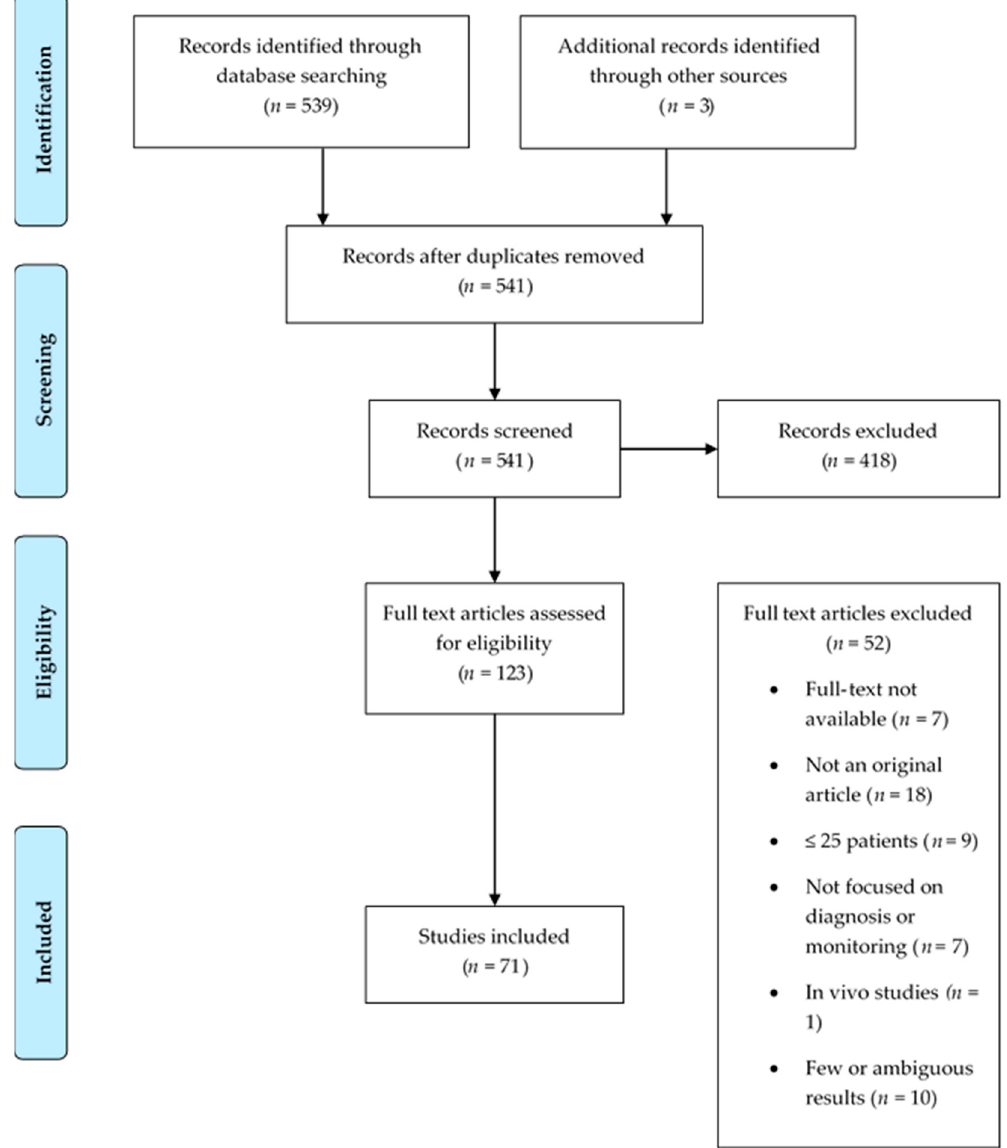
Figure 1. PRISMA flow diagram of the search strategy to retrieve studies included in the review.